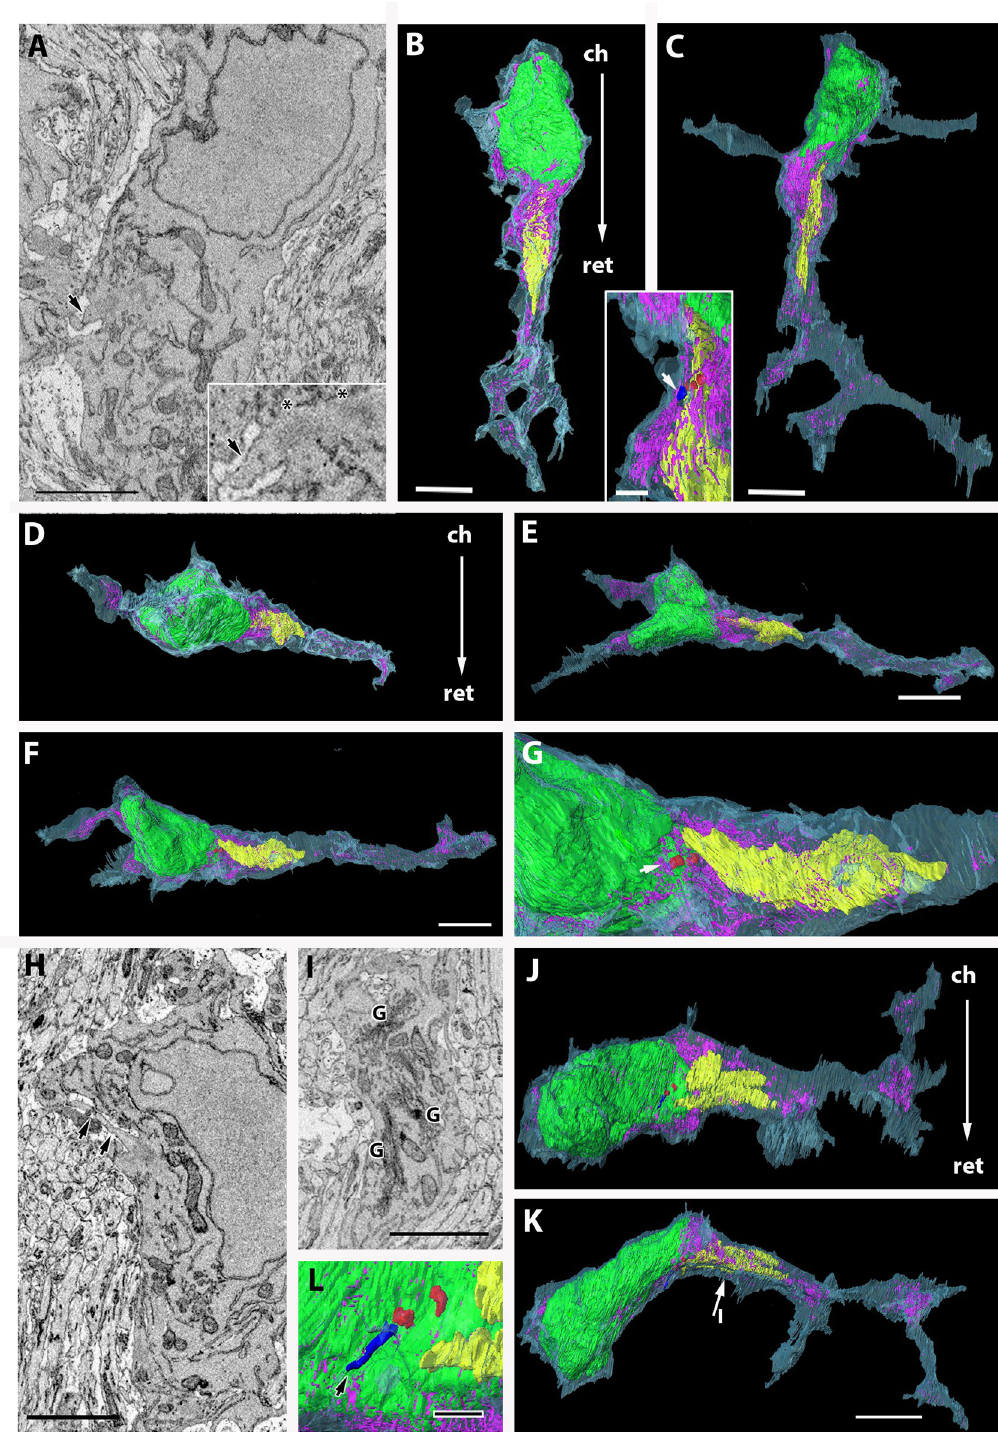
Fig 2. Fine structure and 3D reconstruction of pOPCs. Light blue, cytoplasm. Green, nucleus. Yellow, Golgi apparatus. Magenta, ER. Red, centrioles. Blue, cilium. (A–C) pOPC oriented along the optic nerve axons. (A) A pOPC in the SBF-SEM image. An arrow indicates a short cilium, which is magnified in the inset. A pair of centrioles (basal body) is indicated by asterisks in the inset. (B, C) 3D reconstruction of the pOPC, indicating that this cell is unipolar in shape, extends five processes, and contains a short cilium. Localization of the Golgi apparatus and ER is shown, most of which are close to the nucleus while a